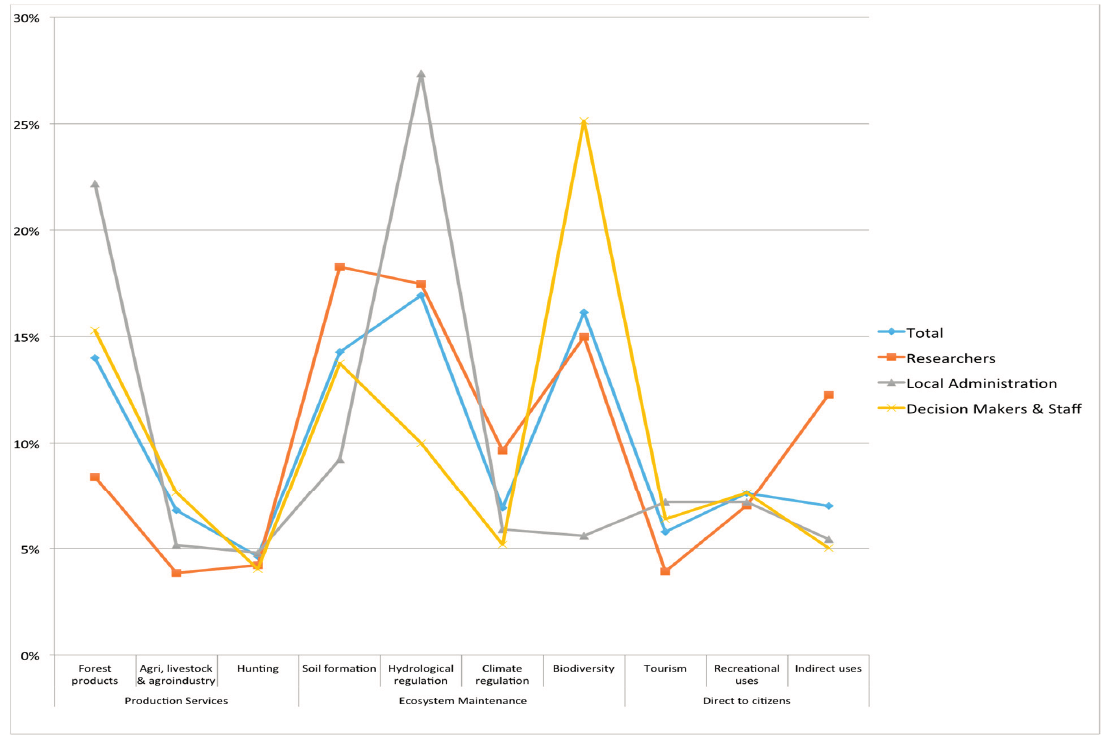
Figure 4. Ecosystem services preferences (%) by stakeholder groups in the Serra d’Espadà Natural